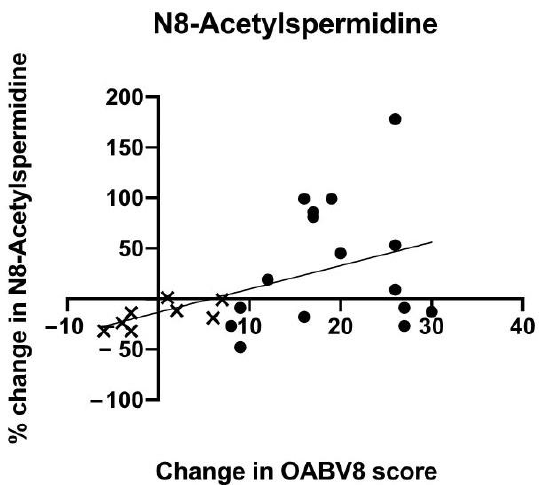
Figure 3. Median regression model showing that the percent change in urinary N8-acetylspermidine levels of patients in the non-responder ( × ) and responder ( • ) groups were directly correlated with changes in OAB-V8 scores after adjusting for age, BMI, diabe tes mellitus, and race/ethnicity. β -co-efficient slope = 2.80 (95% CI 0.04, 5.55), p = 0.047.